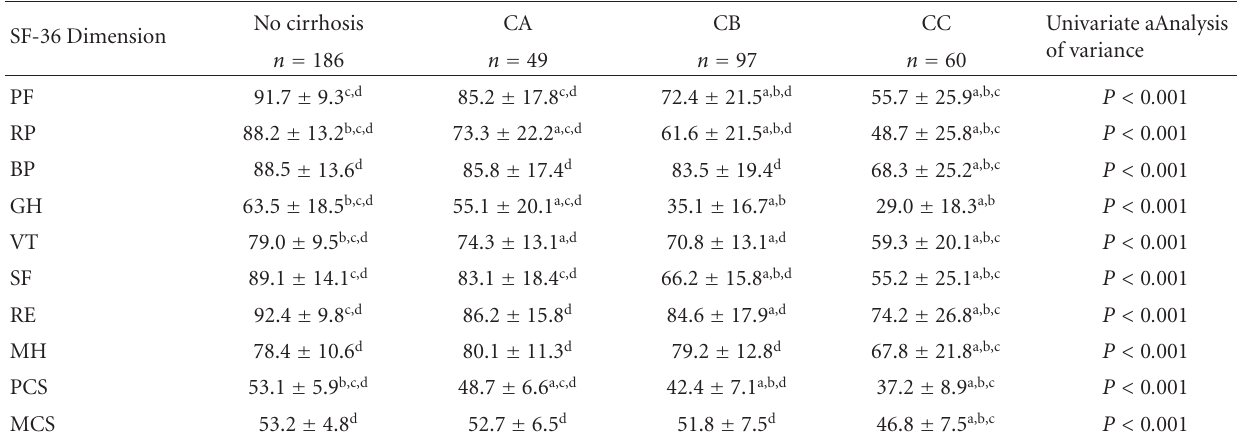
Table 3: HRQOL scores of patients with di ff erent severities of CLD (mean ± SD). SF-36 Dimension